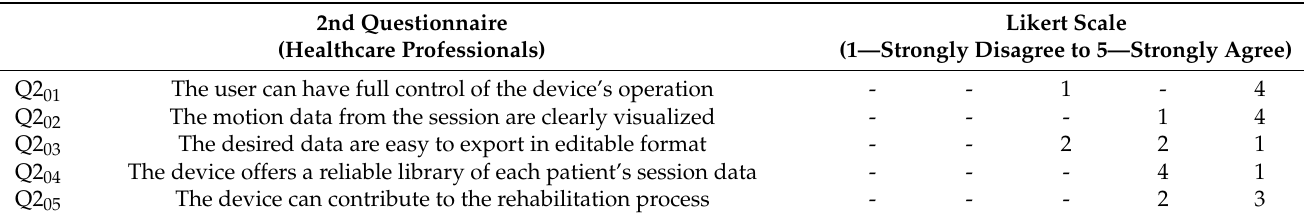
Table 4. The questions of the second questionnaire and the distribution of answers per